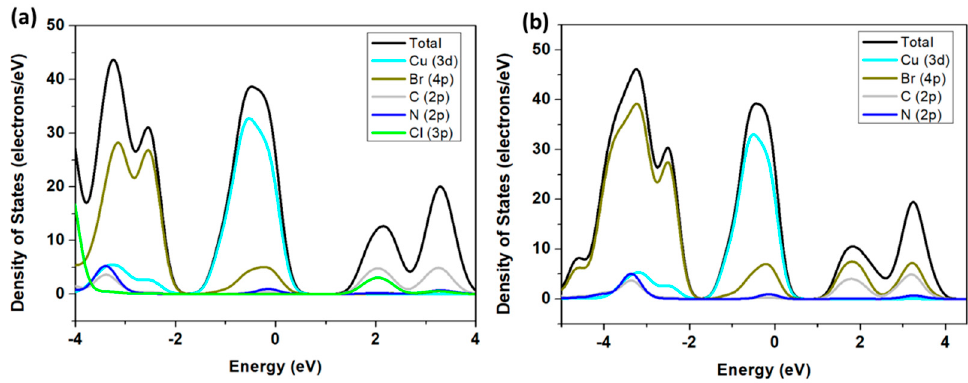
Figure 6. Density of states plots for 1 ( a ) and 2 ( b ).